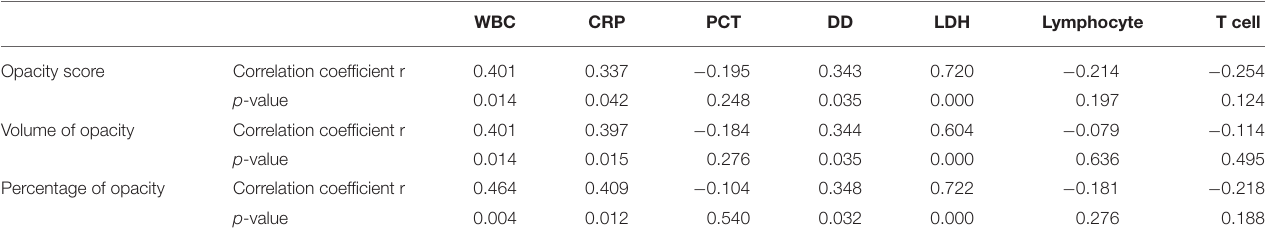
TABLE 3 | Correlations of CT quantitative parameters with laboratory tests.